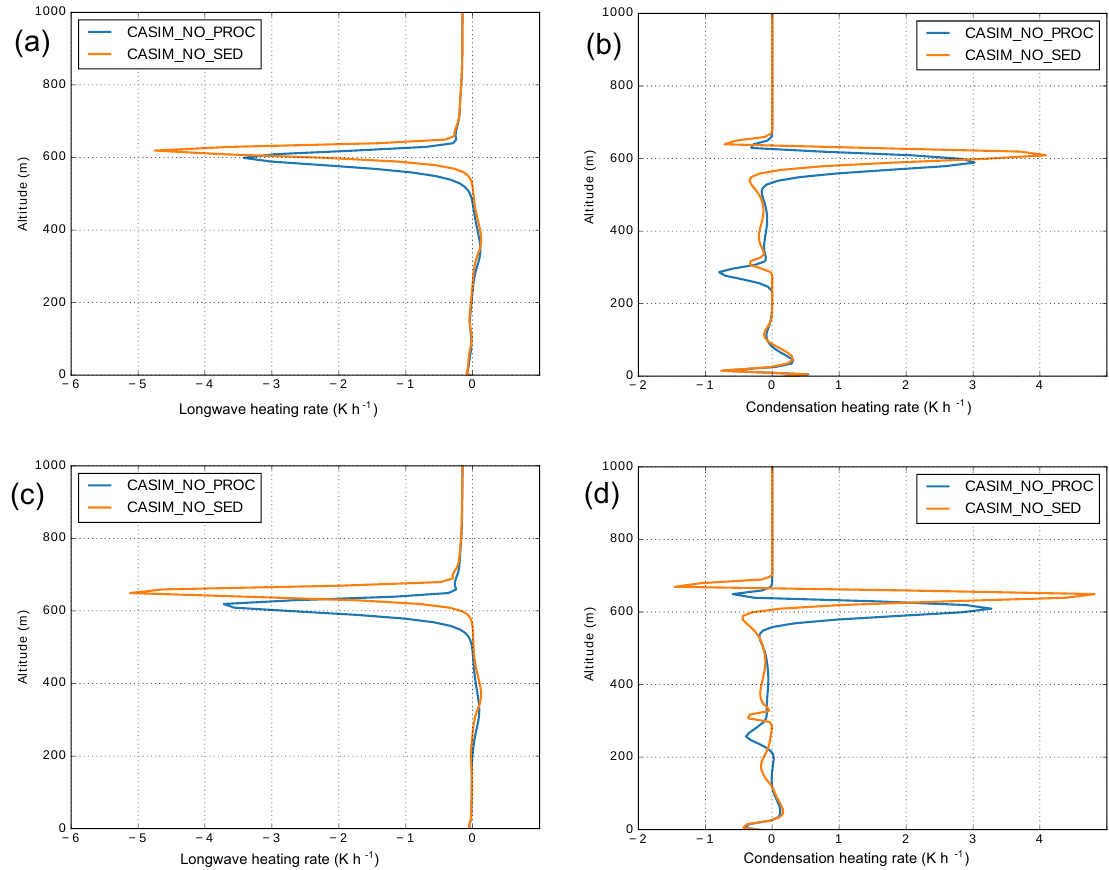
Figure 11. Domain-average vertical profiles of (a) longwave radiative heating rate (Kh − 1 ) and (b) condensation heating rate (Kh − 1 ) calculated as temporal means between 05:00 and 05:30UTC for CASIM_NO_PROC (blue) and CASIM_NO_SED (orange). Longwave and condensation heating rates for the period 06:30–07:00UTC are shown in (c) and (d)